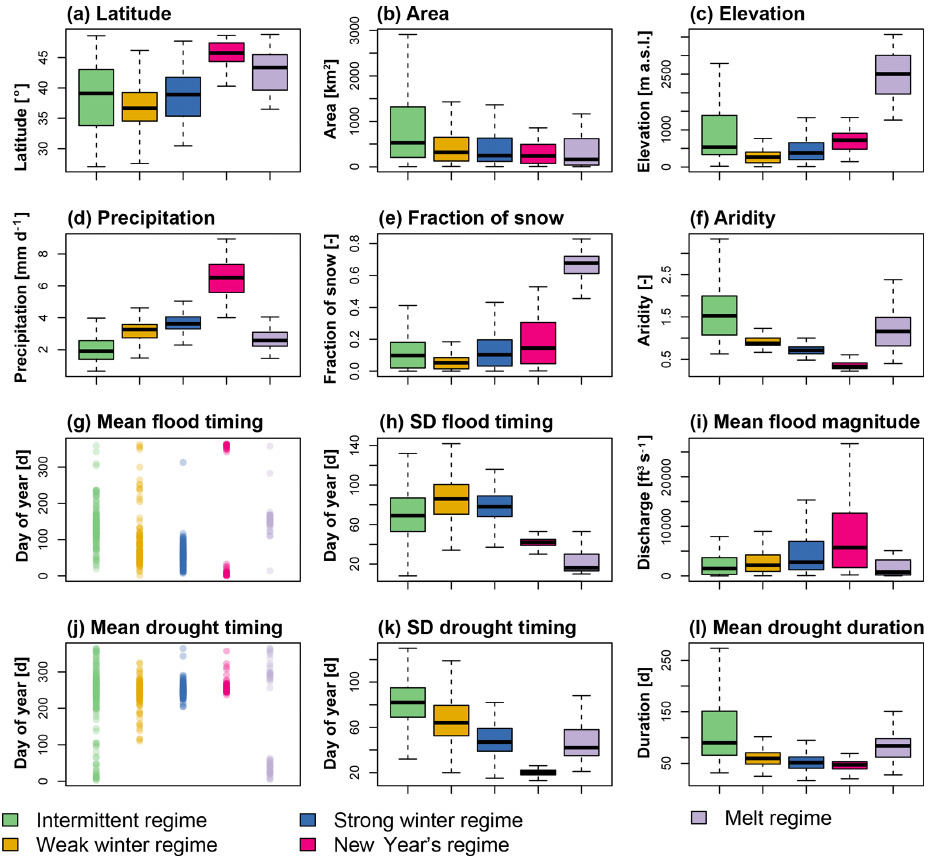
Figure 3. Catchment (a–f) , flood (g–i) , and drought characteristics (j–l) of the catchments belonging to the five regimes: intermittent, weak winter, strong winter, New Year’s, and melt. Characteristics (a–f) were derived from the CAMELS dataset, the flood and drought characteristics using a peak-over-threshold or threshold-level approach, respectively. SD: standard deviation. The black lines in the boxplot indicate the median and the upper and lower whiskers correspond to 1 . 5 × R IQ , where R IQ is the inter-quartile range. Outliers are not